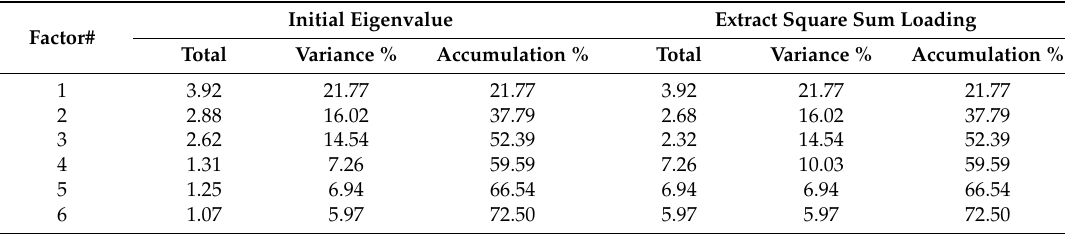
Table 4. Total variance explained by the job stress questionnaire.